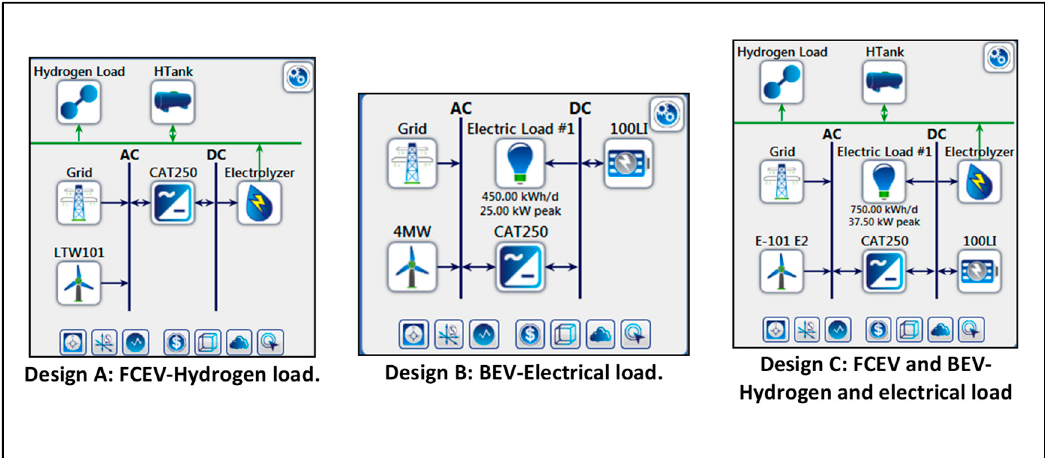
Figure 6. System configuration for different designs in the hybrid optimization model for electric renewables (HOMER).